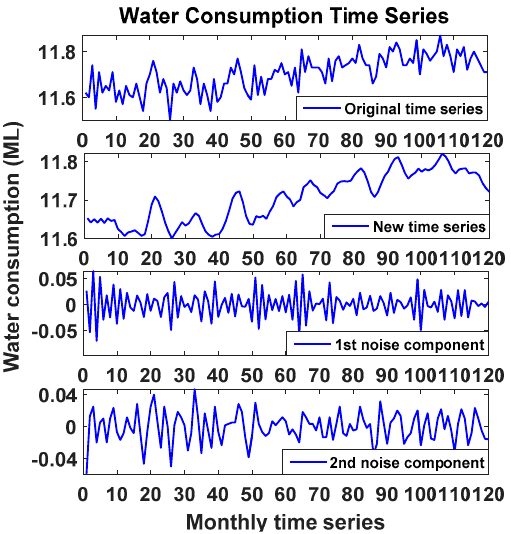
Figure 2. Original time series (top row) and three components of water consumption obtained by the pre-treatment signal technique (2nd to 4th rows). The 2nd row represents the new time series, while the 3rd and 4th represent noise.